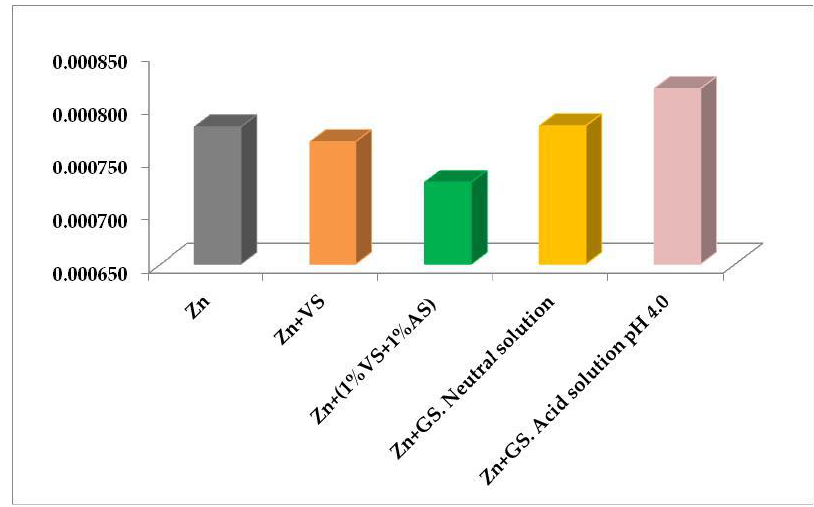
Figure 10. Effect of metal surface pre-modification with formulations based on organosilanes on the corrosion of zinc in the electrolyte. Accelerated corrosion tests in 0.1 M sodium chloride solution. Test duration: 66 days. Corrosion rates were determined by the gravimetry method. Table 4. Effect of preliminary modification of the metal surface with formulations based on organosi- lanes on the atmospheric corrosion of zinc. Accelerated corrosion tests, climate chamber, T = 60 ◦ C; RH = 95%. Tests duration: 51 days. Corrosion rates were determined by the gravimetry method.